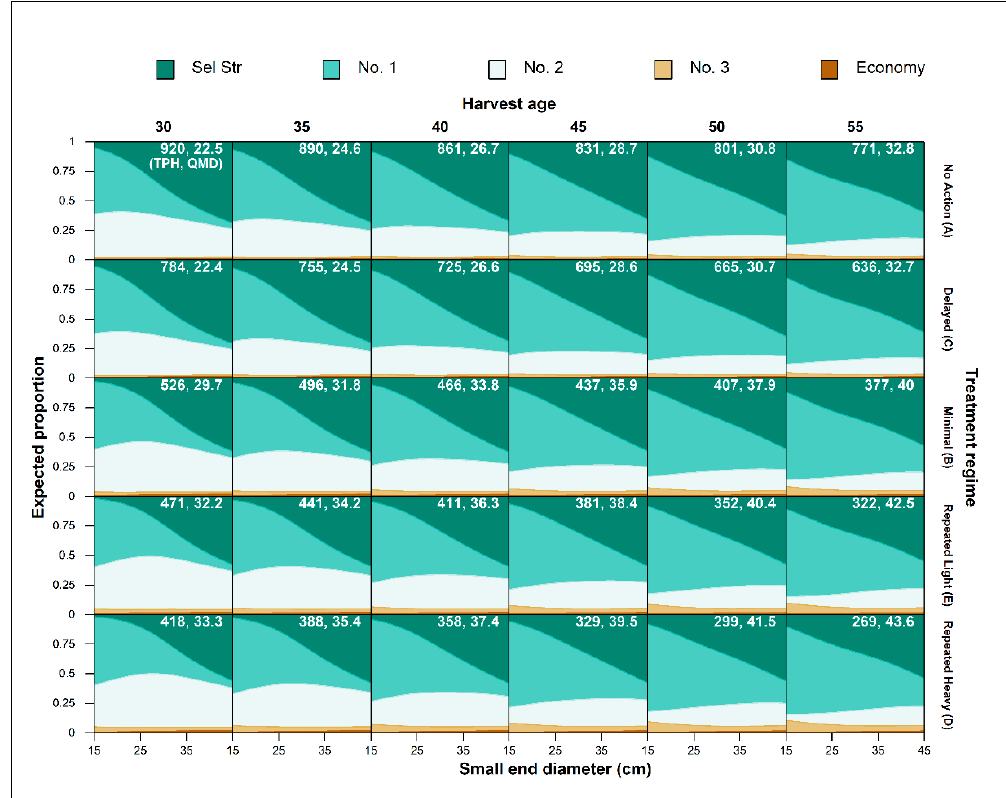
Figure 5. Expected proportion of log volume by lumber visual grade by harvest age, treatment regime, and log small end diameter. Trees per hectare (TPH) and quadratic mean diameter (QMD) for each rotation age by treatment panel are shown in the upper right corner.